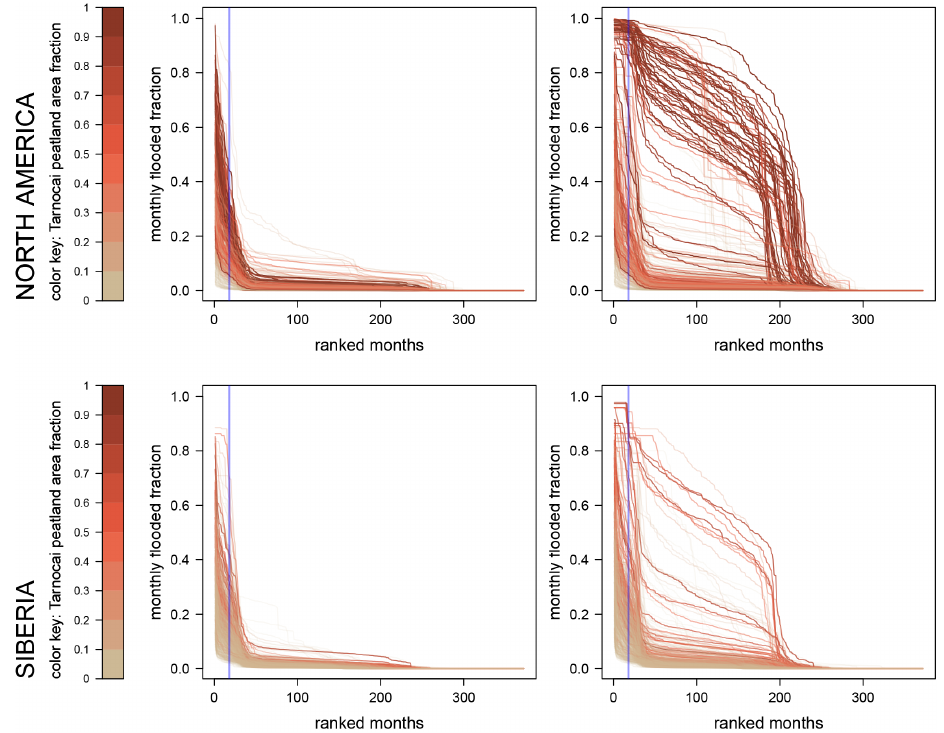
Figure 4. Ranked monthly flooded area fraction f for a 31years period (1982–2012) and for two regions comprising the Hudson Bay Lowlands (70–110 ◦ W/48–58 ◦ N, top) and the West Siberian Lowlands (50–180 ◦ E/60–65 ◦ N, bottom). Each line represents one grid cell. The monthly flooded area fractions are compared to observation-based data of peatland area fraction (Tarnocai et al., 2009) by colouring the line for each grid cell accordingly (see colour key). f is calculated as a function of the water table position computed by LPX for mineral soils only (left) and for the grid-cell area fraction-weighted mean (cid:48) (right, see Eq. 8), i.e. before and after peatland establishment. The vertical blue line is drawn at ranked months = 18, representing the model parameter N in Eq. (13). The intersect of a given line with the blue line defines f pot peat in the respective grid